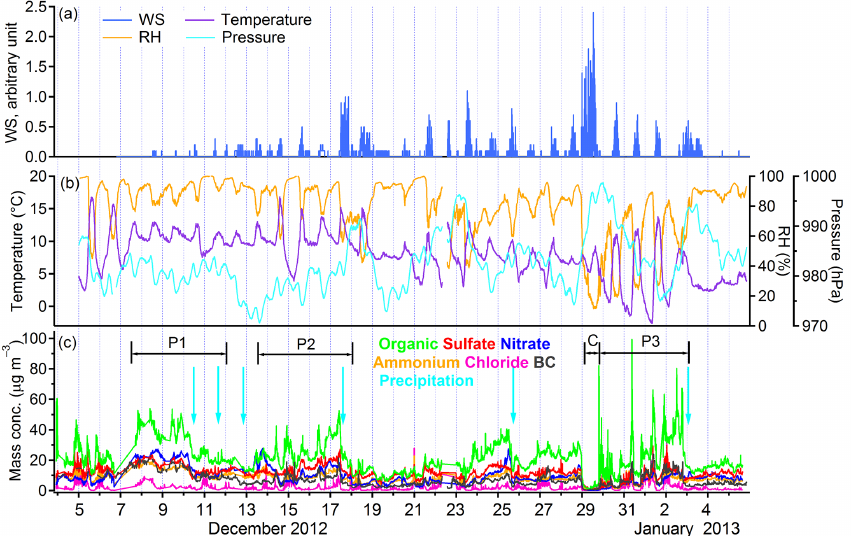
Figure 2. Time series of meteorological parameters and concentrations of chemical compositions in submicron aerosols during the campaign. (a) Wind speed (WS), relative values; (b) relative humidity (RH), temperature and atmospheric pressure; (c) concentrations of chemical compositions in submicron aerosols. Short-term precipitation events are marked by the light blue